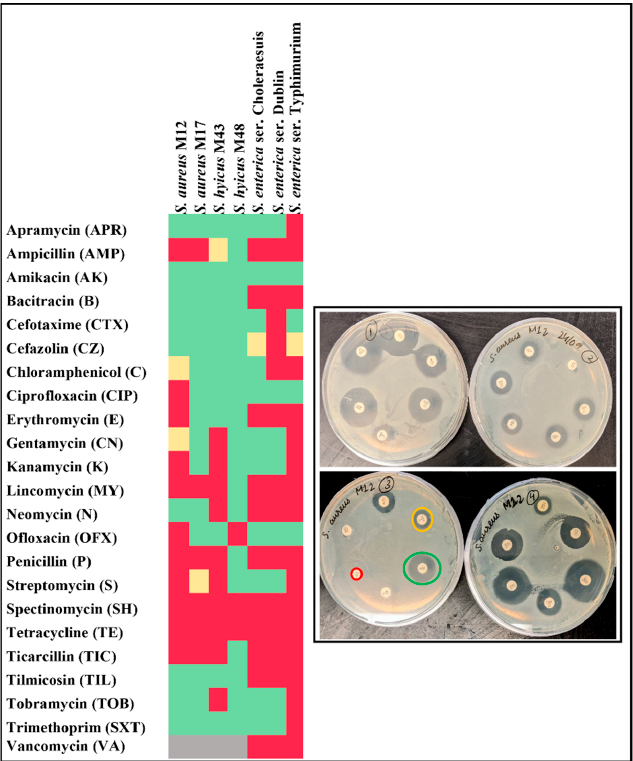
Figure 1. Antimicrobial susceptibility of bacterial isolates: Antimicrobial susceptibility of bacterial isolates was tested using the Kirby–Bauer disk diffusion assay. Disks containing antibiotics were placed on the lawn of bacteria and incubated overnight at 37 °C (as seen in the inlet). The zone of inhibition was measured, and isolates were categorized as resistant (red), intermediate (yellow), susceptible (green), or not applicable (grey) according to CLSI guidelines.